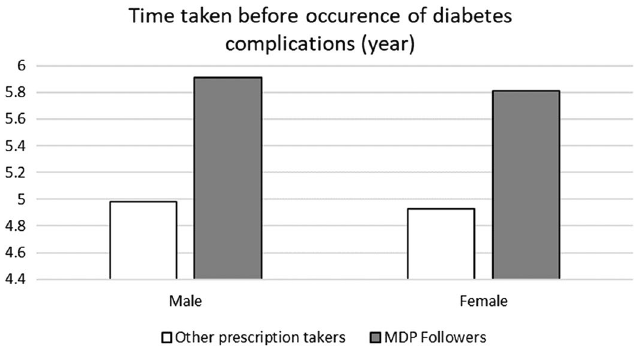
Figure 5. A comparison of the diabetic complication occurrence period between MDP recommendation followers and other prescription users. This figure shows the average period from the time diabetes was diagnosed to the occurrence of complications, and compared the MDP follower groups and other group. Grey shaded sqaure is for MDP follower group and Open square is for other prescription taker